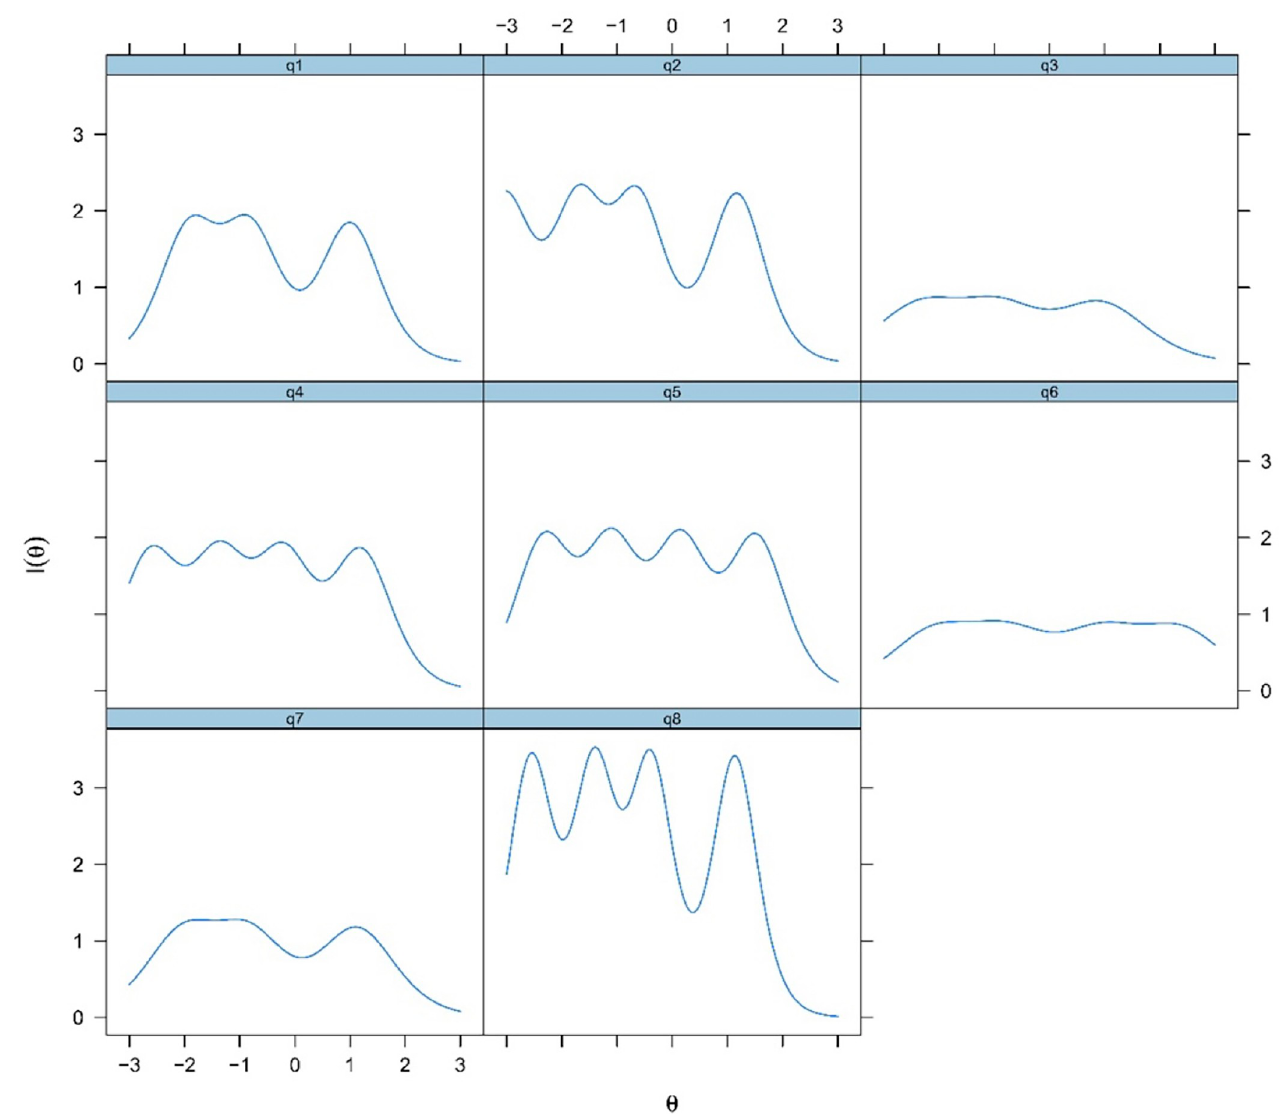
Fig 3. Item information curves of the